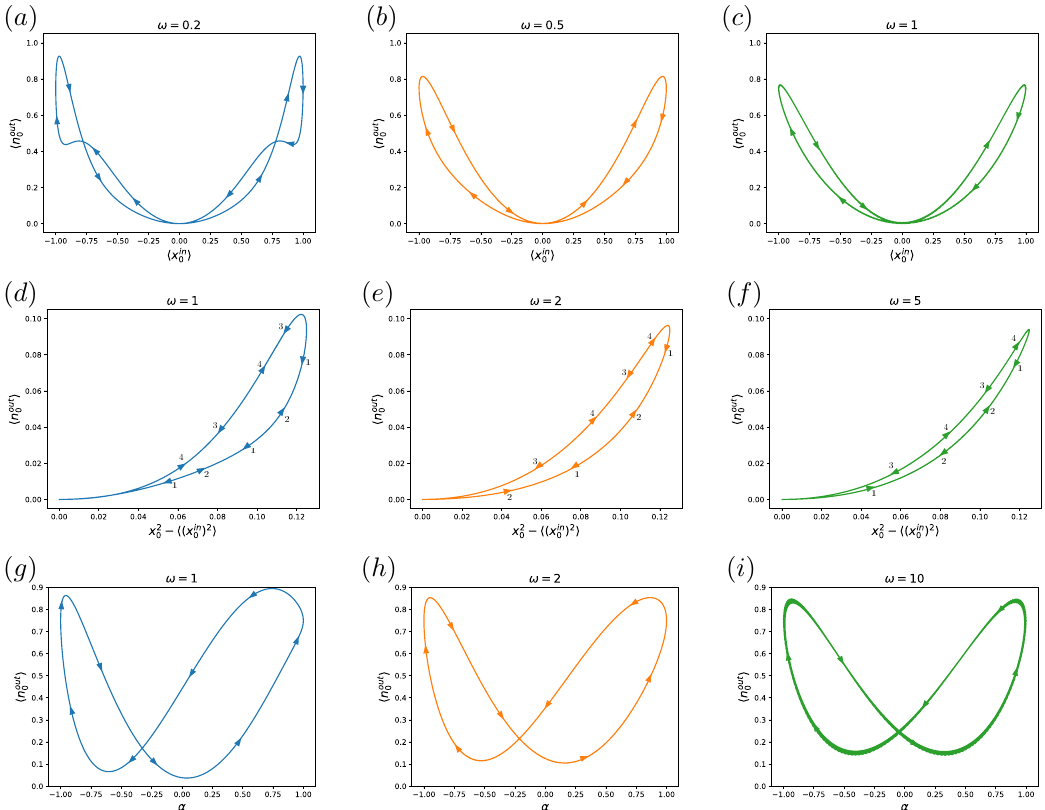
(cid:105) of the outgoing beam versus the corresponding control variable Figure A1. Number of photons (cid:104) n out 0 for coherent, squeezed, and Fock state inputs, for different driving frequencies: ( a – c ) coherent states; ( d – f ) squeezed states; and ( g – i ) Fock states. Since the control is always positive for squeezed states, we introduce a number to illustrate the order of the arrows in the hysteresis